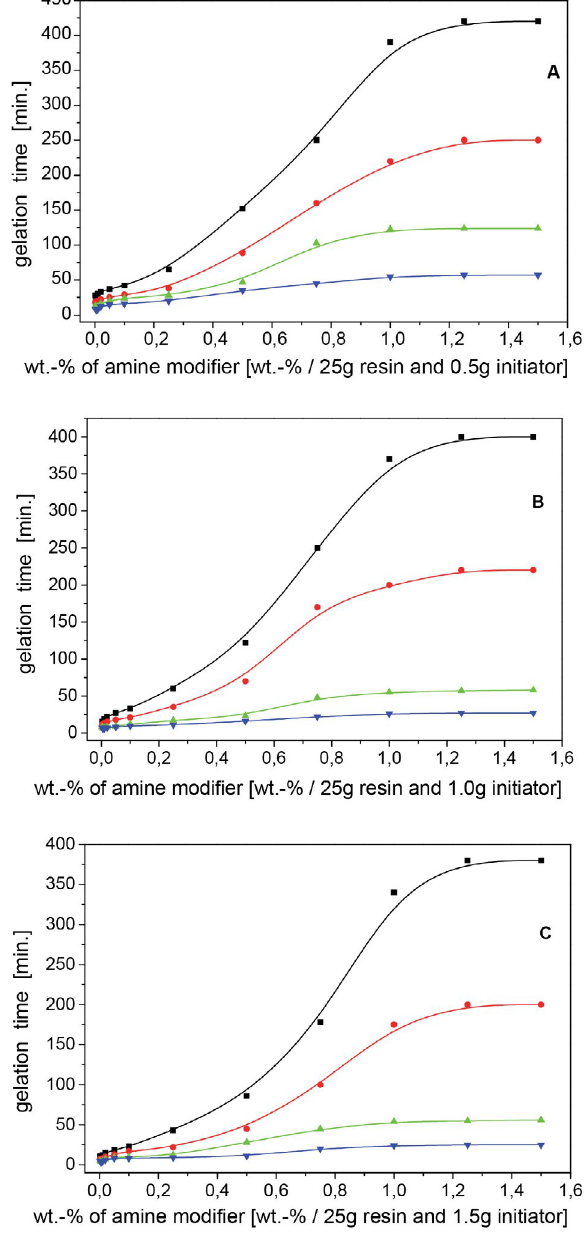
Figure 4. Gelation times of unsaturated polyesters resins with vari- ous amount of chemically incorporated modifier B and cobalt accel- erator. To 25 g of resin, 0.5 g (plot A), 1.0 g (plot B), and 1.5 g (plot C) of butanone peroxide initiator was added; the amounts of cobalt accelerator: ( ■ ), 0.10 mL; ( • ), 0.15 mL; ( ▲ ), 0.25 mL; ( ▼ ), 0.50 mL.